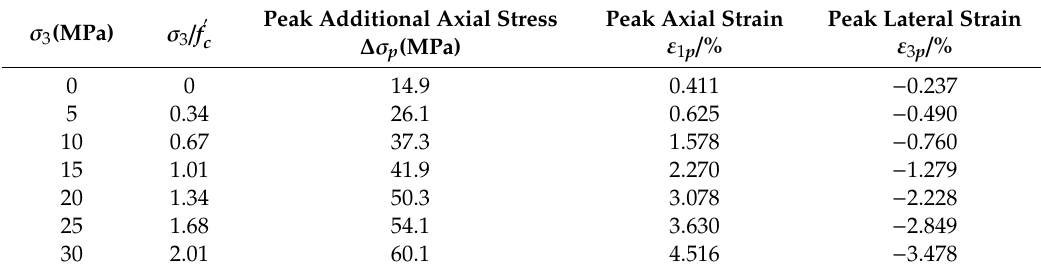
Figure 1. Axial deviatoric stress versus strain curves for RCC samples under confining pressures. Table 2. Triaxial compression results of RCC.